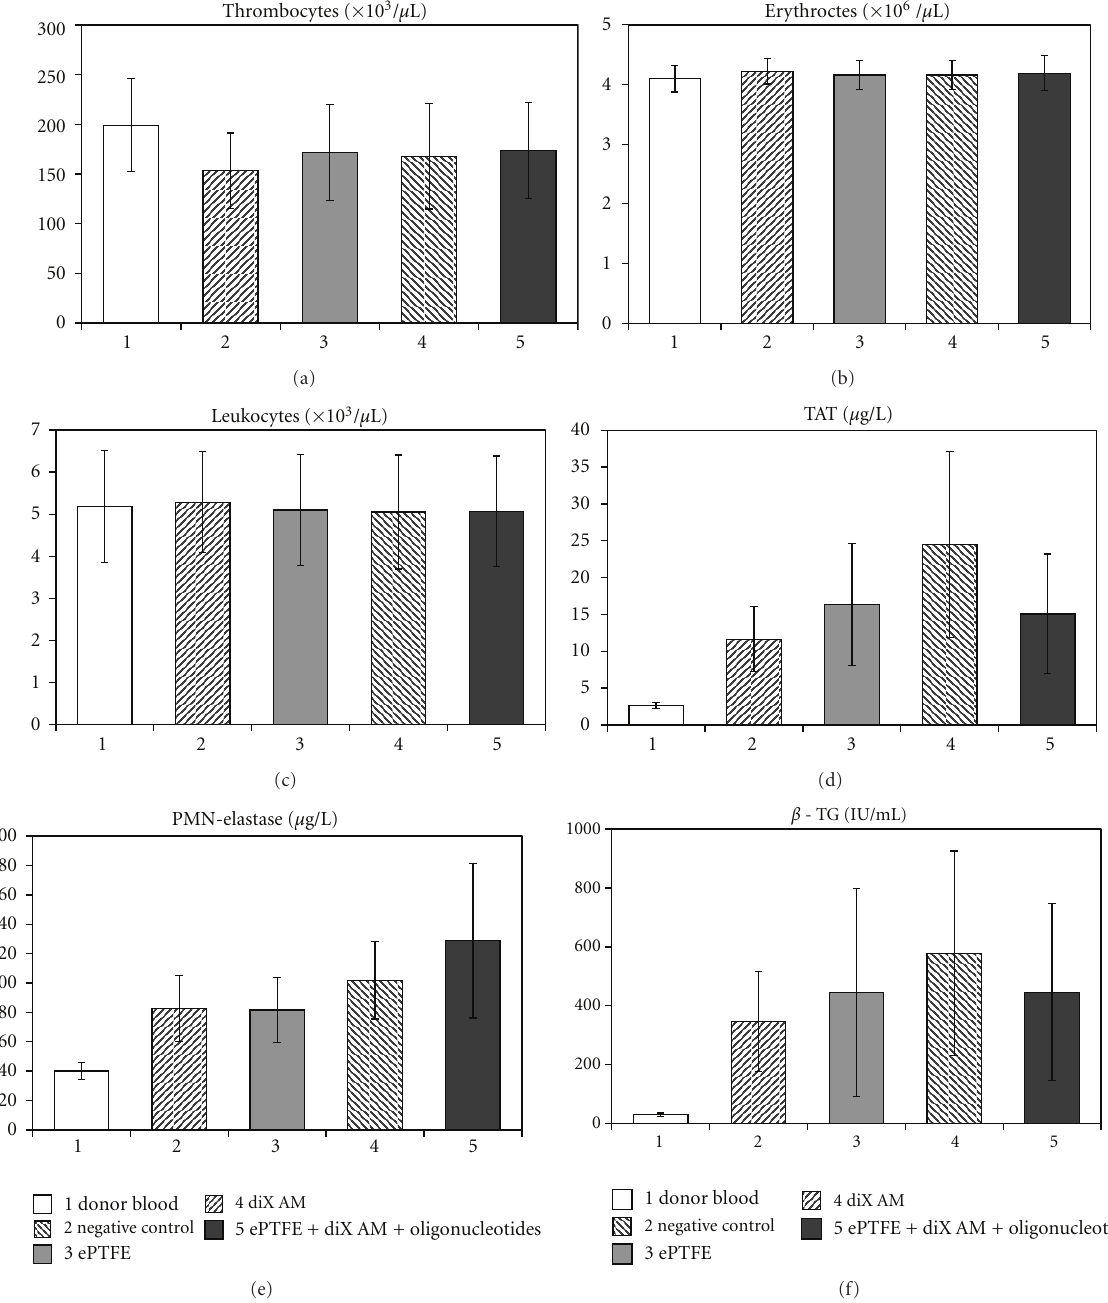
Figure 11: Hemocompatibility testing of oligonucleotide coated diX AM surfaces. Samples were incubated with human whole blood for 1 h at 37 ◦ C under continuous shaking. Cell number and di ff erent factors, which give information about the activation of thrombocytes ( β -TG), granulocytes (PMN-Elastase) and the coagulation system (TAT) were measured in the supernatant. ANOVA tests revealed no significant di ff erence between the groups ( P > 0 . 05, n =